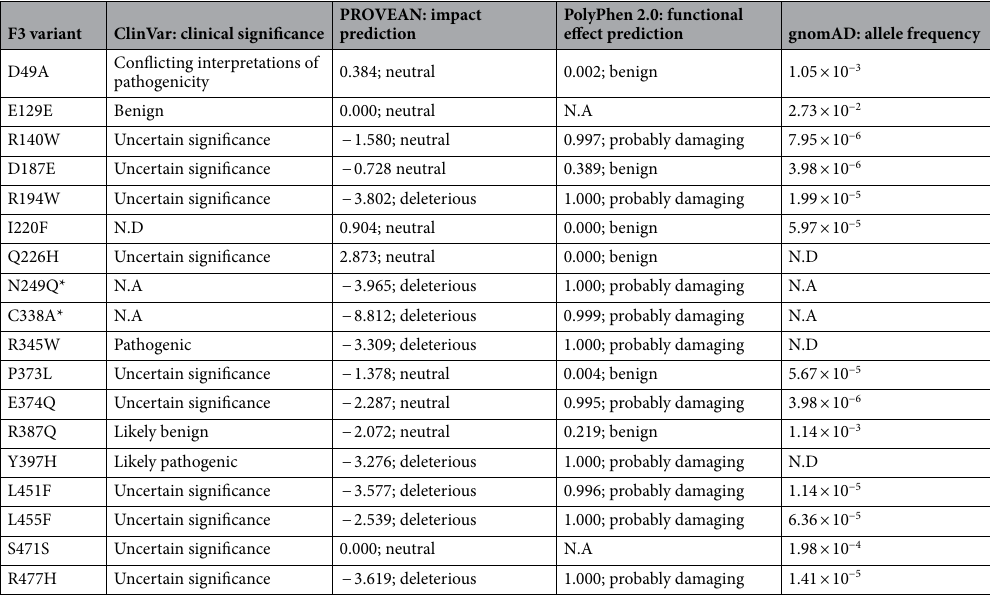
Table 1. Clinical signficance, predicted stability scores, and allele frequencies of F3 variants. *Indicates rationally-designed